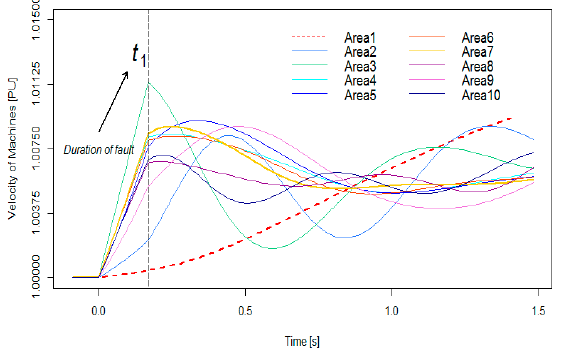
Figure 6. Speed of the machines for a three-phase fault in Line 4-5 and cleared at 0.17 s.